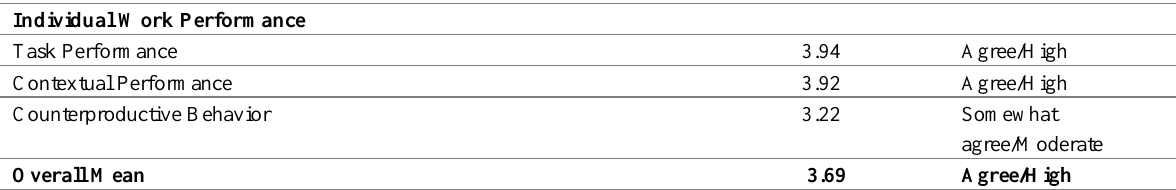
Table 11: Summary Table: Individual Work Performance